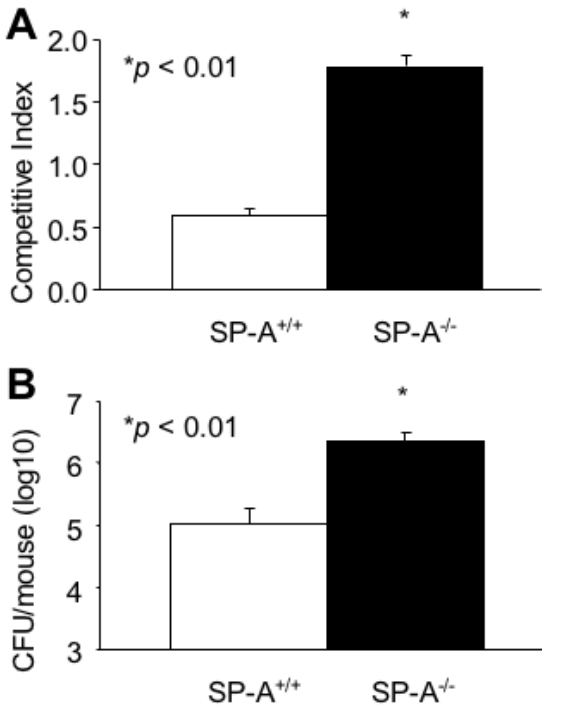
Figure 2. The flgEMutant Is Attenuated in SP-A + / + Mice. (A) In vivo competition between the PA01 and flgE was assessed after intranasal pulmonary inoculation of 6-week old SP-A + / + and SP-A 2 / 2 mice. The mean competitive index (CI) was calculated from bacterial colonies recovered 16 hr after infection. The competitive index (CI) is defined as the output ratio of mutant to wild-type bacteria divided by the input ratio of mutant to wild-type bacteria. Data are the mean 6 SE, n =4. * p , 0.05. (B) Single respiratory tract infection of flgE mutant bacteria was performed by intranasal inoculation in SP-A + / + and SP-A 2 / 2 mice. CFU were counted in lung homogenates 16 hr after inoculation. Data are the mean CFU 6 SE, n=5. * p , 0.01.